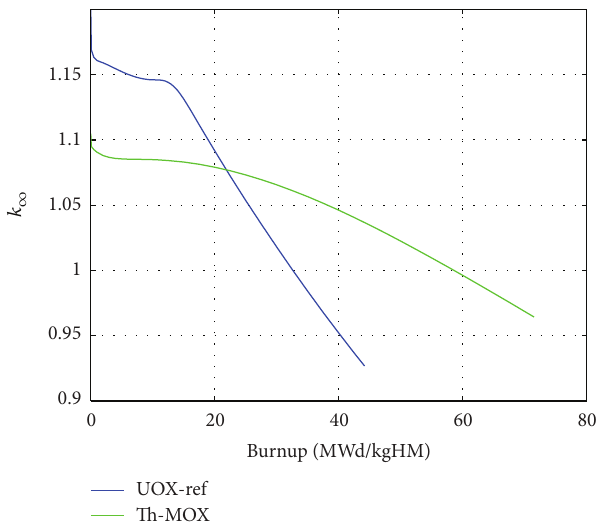
Figure 5: Infinite multiplication factor dependence on burnup.